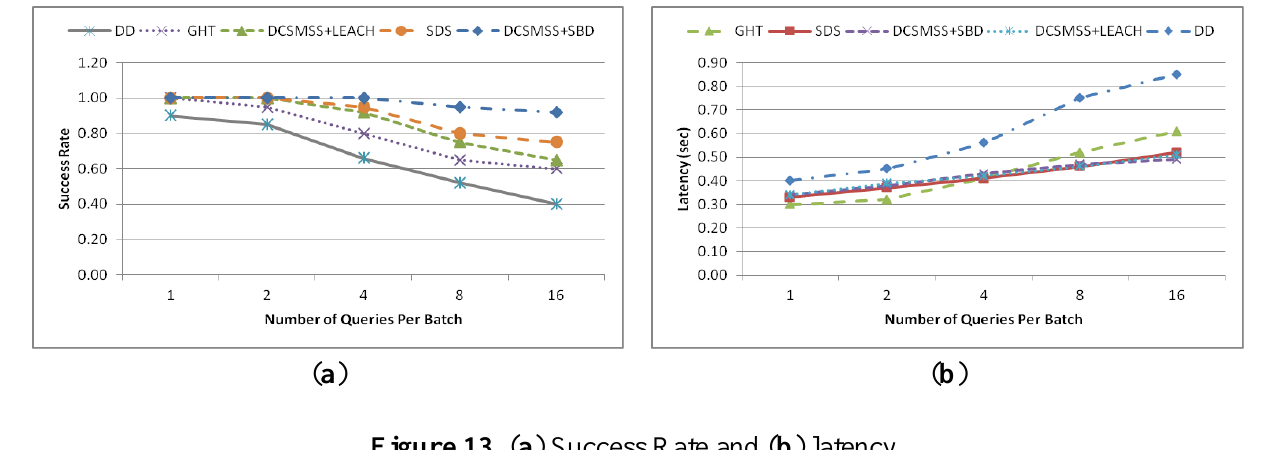
Figure 13. ( a ) Success Rate and ( b )